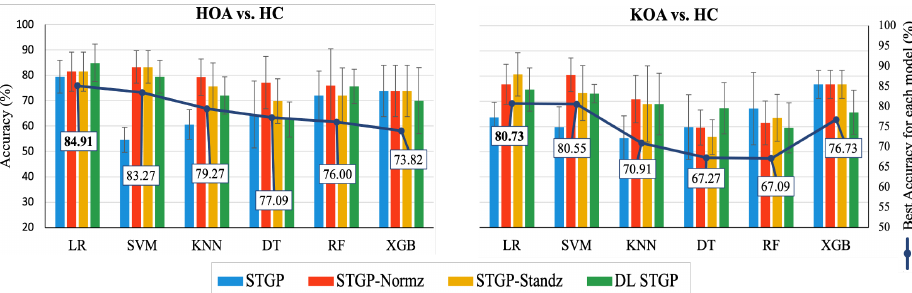
Figure 14. Accuracy of baseline models using raw STGP and rescaled STGP data. The white rectangular boxes represent the best accuracy for each ML model.